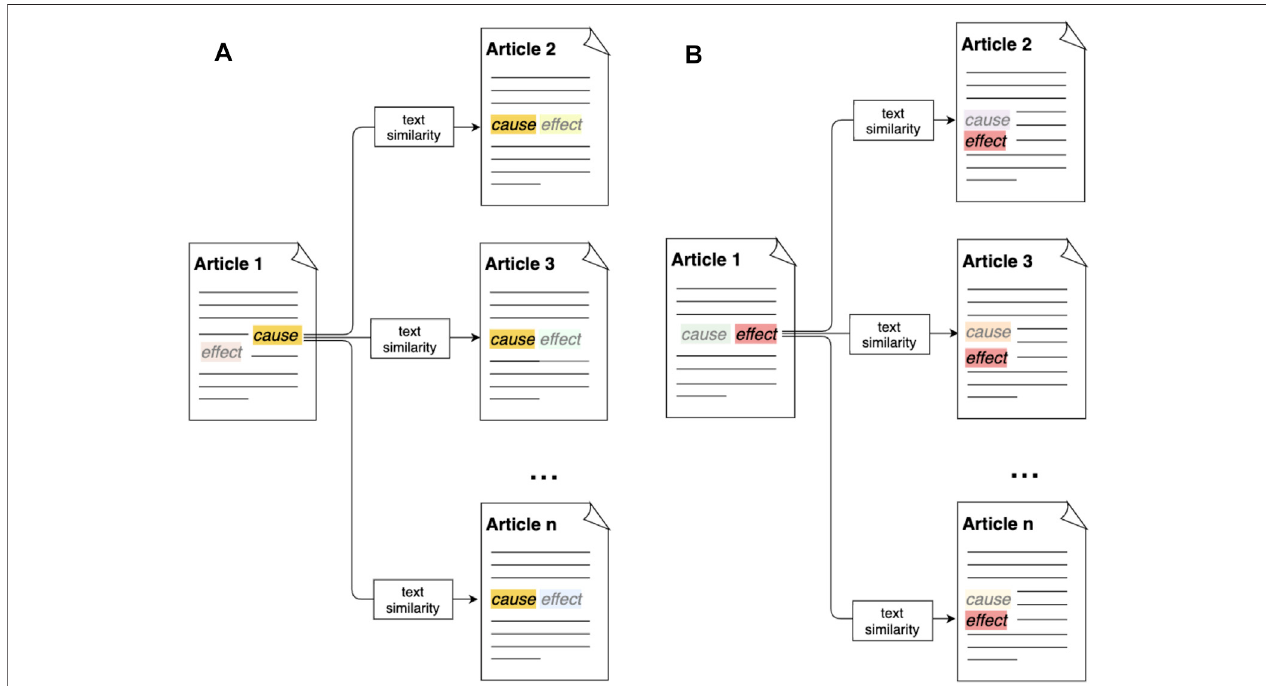
FIGURE 1 | Main working principle of the Penelope opinion facilitator. First, causation frame instances consisting of a “ cause ” frame element and an “ effect ” frame element are automatically extracted from news articles on climate using the Penelope semantic frame extractor. Figure 1A (A) shows how, subsequently, for a given “ cause ” frameelement,thesystemisabletoretrievearticlesexpressingalternative “ effect ” frameelementsbasedonmeasuresfortextsimilarity. Figure1B(B) illustrates how, conversely, the system can retrieve articles containing alternative “ cause ” frame elements for a given “ effect ” frame element. Through this mechanism, the system exposes a reader to alternative perspectives on the same issue.